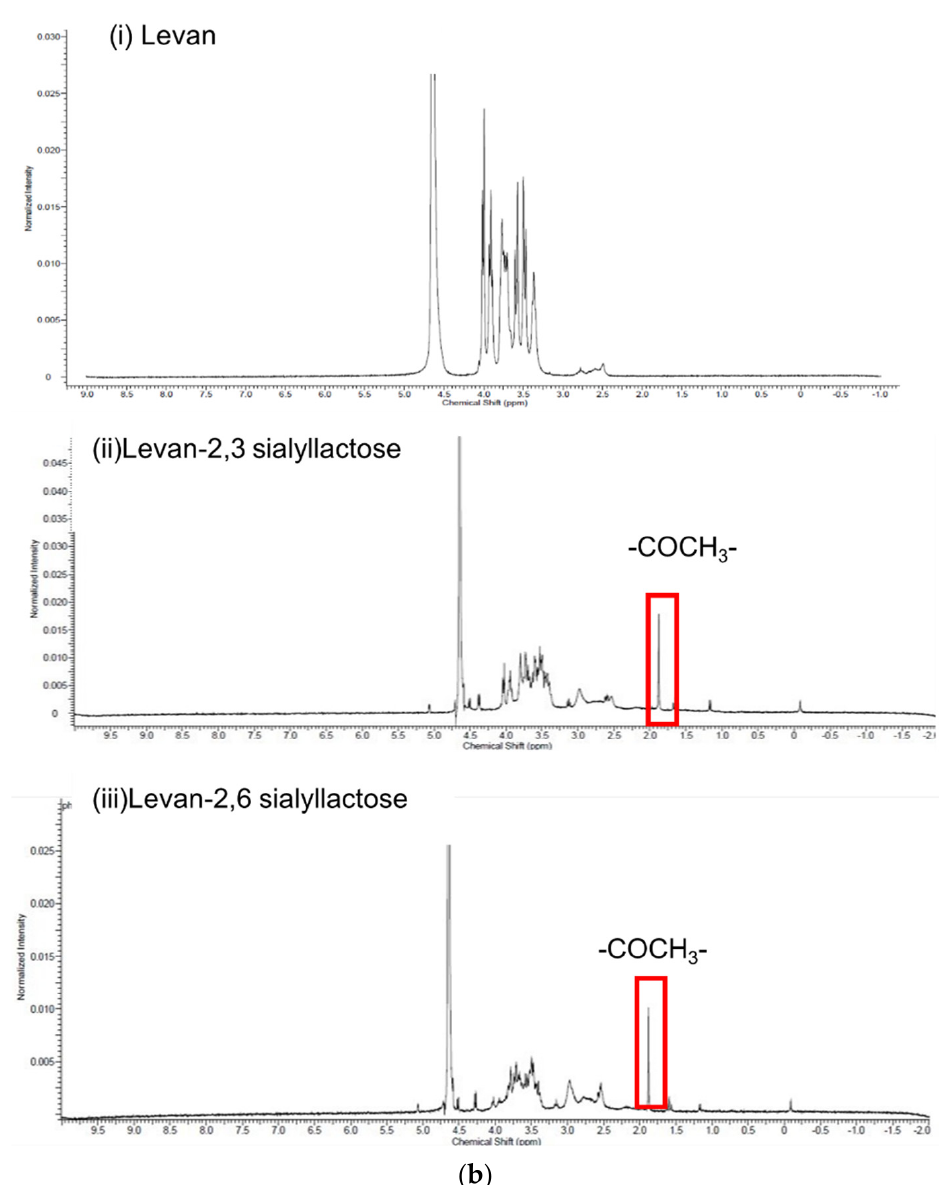
Figure 1. Confirmation of sialyllactose conjugated levan determined by FTIR (3200–3300 cm − 1 , O-H; 2930 and 2880 cm − 1 , C-H; 1720 cm − 1 , C-O amide I; and 950–1200 cm − 1 , fingerprint region) ( a ) and NMR ( b ) ((i) levan, (ii) 2, 3-sialyllactose-conjugated levan, (iii) 2, 6-sialyllactose-conjugated levan) (3.2–4.2 ppm, glycoside moiety; 1.9 ppm COCH 3 ).